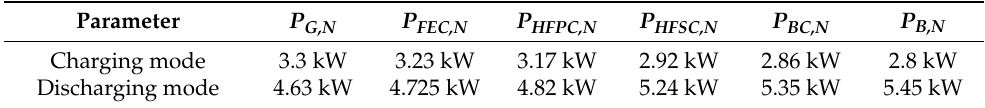
Table 3. Power exchanged in the BWV2G stages.